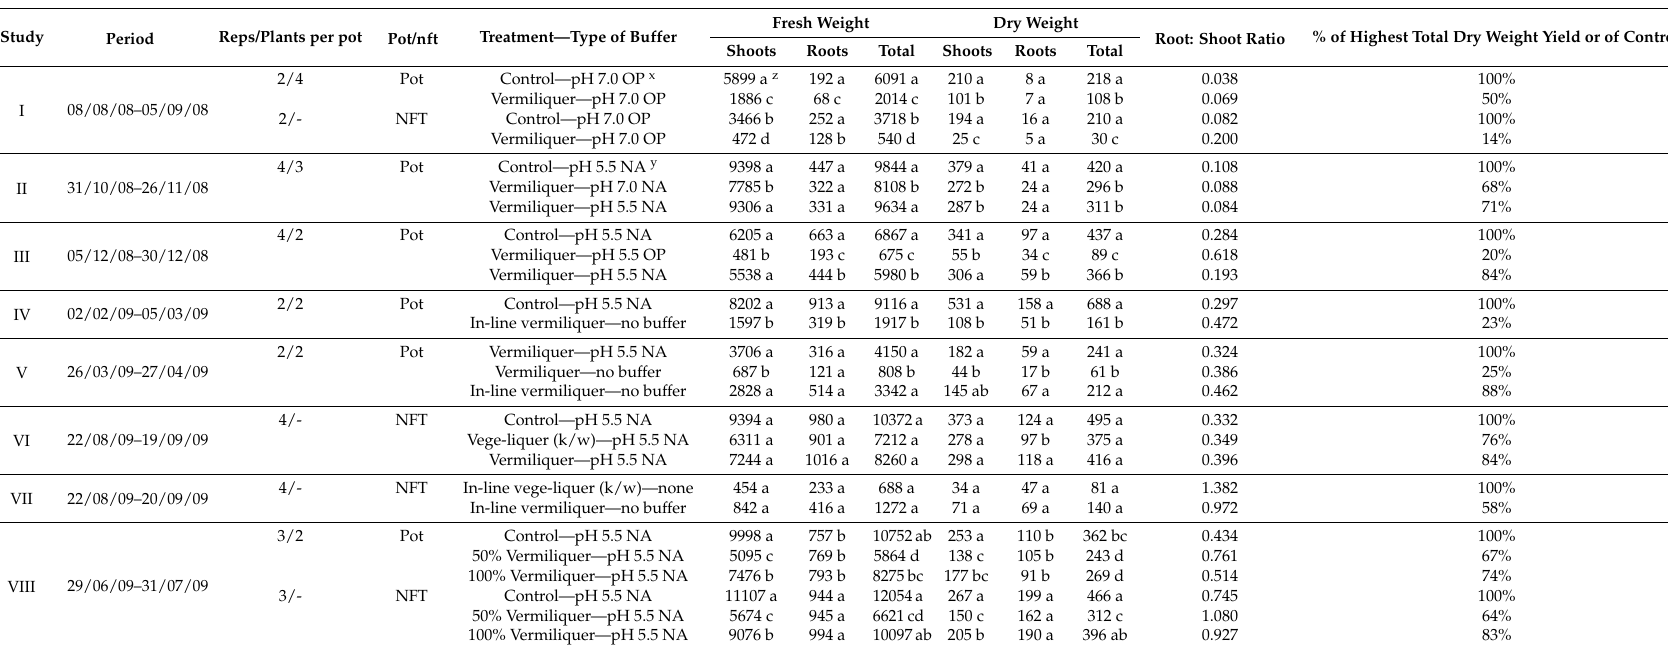
Table 2. Yield and plant biomass parameters of pak choi at harvest (g/m 2 ) in each of the studies. The batch system was used unless stated otherwise. Paunch compost was used unless kitchen waste (k/w) is